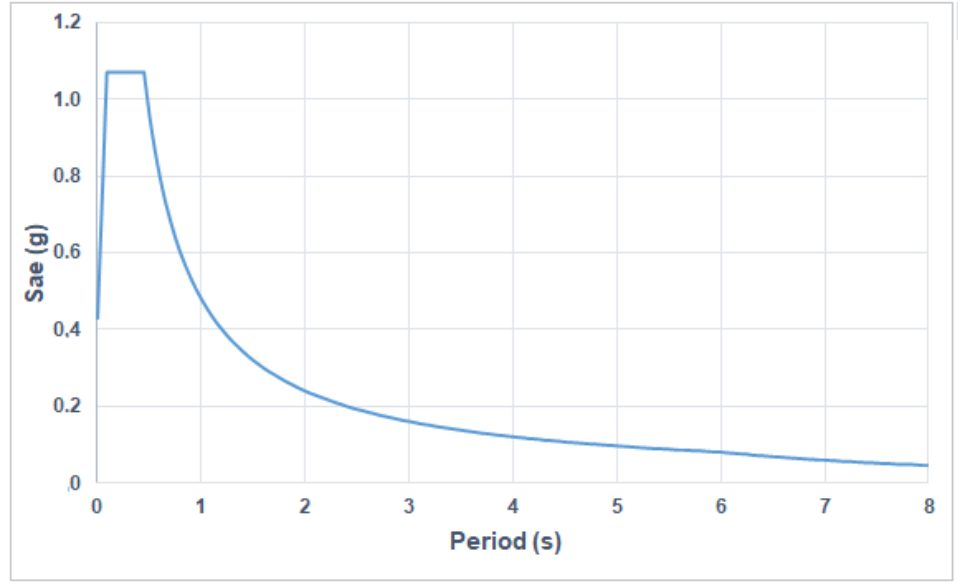
Figure 5. Design spectrum for structural analyses.